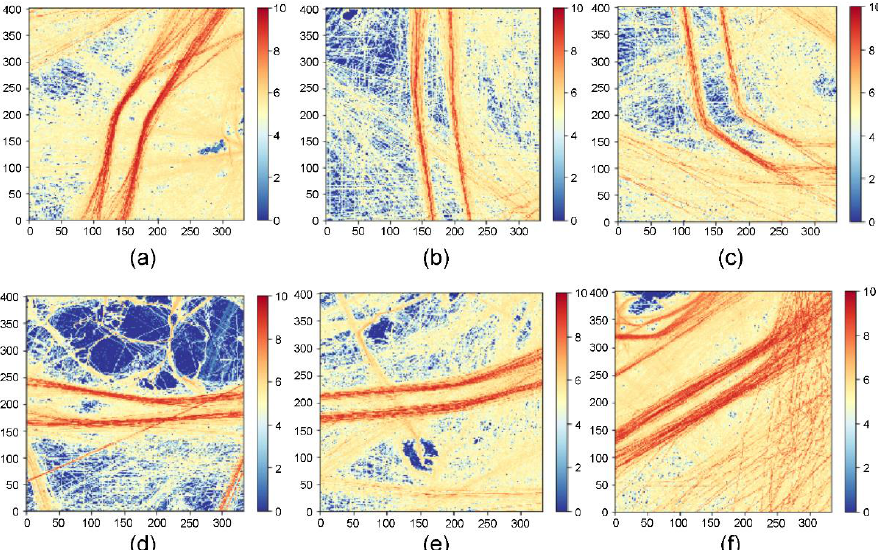
Figure 14. Comparison of vessel traffic indices among designated routes in Korean coastal waters: ( a ) Ongdo area, ( b ) Bukmaemulsudo area, ( c ) Nammaemulsudo area, ( d ) Bogildo area, ( e ) Geomundo area, and ( f ) Hongdo Namhae area.